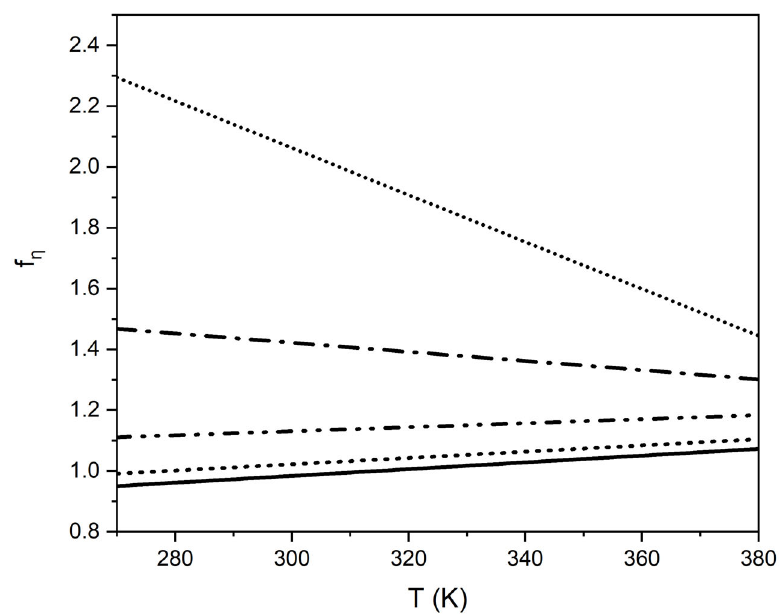
Figure 10. The factors f η = a η + b η · T in Equation (30) of 5 compounds as a function of temperature T K. From bottom to the top at low temperatures: n-heptane, ethyl-acetate, benzene, methanol, water.